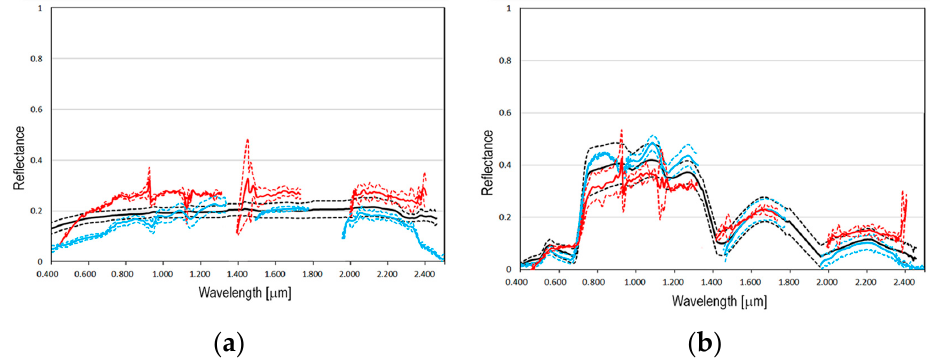
Figure 2. Comparison of the spectra acquired in situ (black) with the spectra of the Hyperion (red) and PRISMA (blue) atmospherically corrected images (the mean spectrum was plotted with a solid line, and the mean spectrum plus the standard deviation and minus the standard deviation were plotted with dashed lines): ( a ) asphalt spectra of the runways of Marco Polo International Airport (Figure 1b shows the site location using the number 1); ( b ) grass spectra of the Malamocco Golf Club (Figure 1b shows the site location using the number 2).